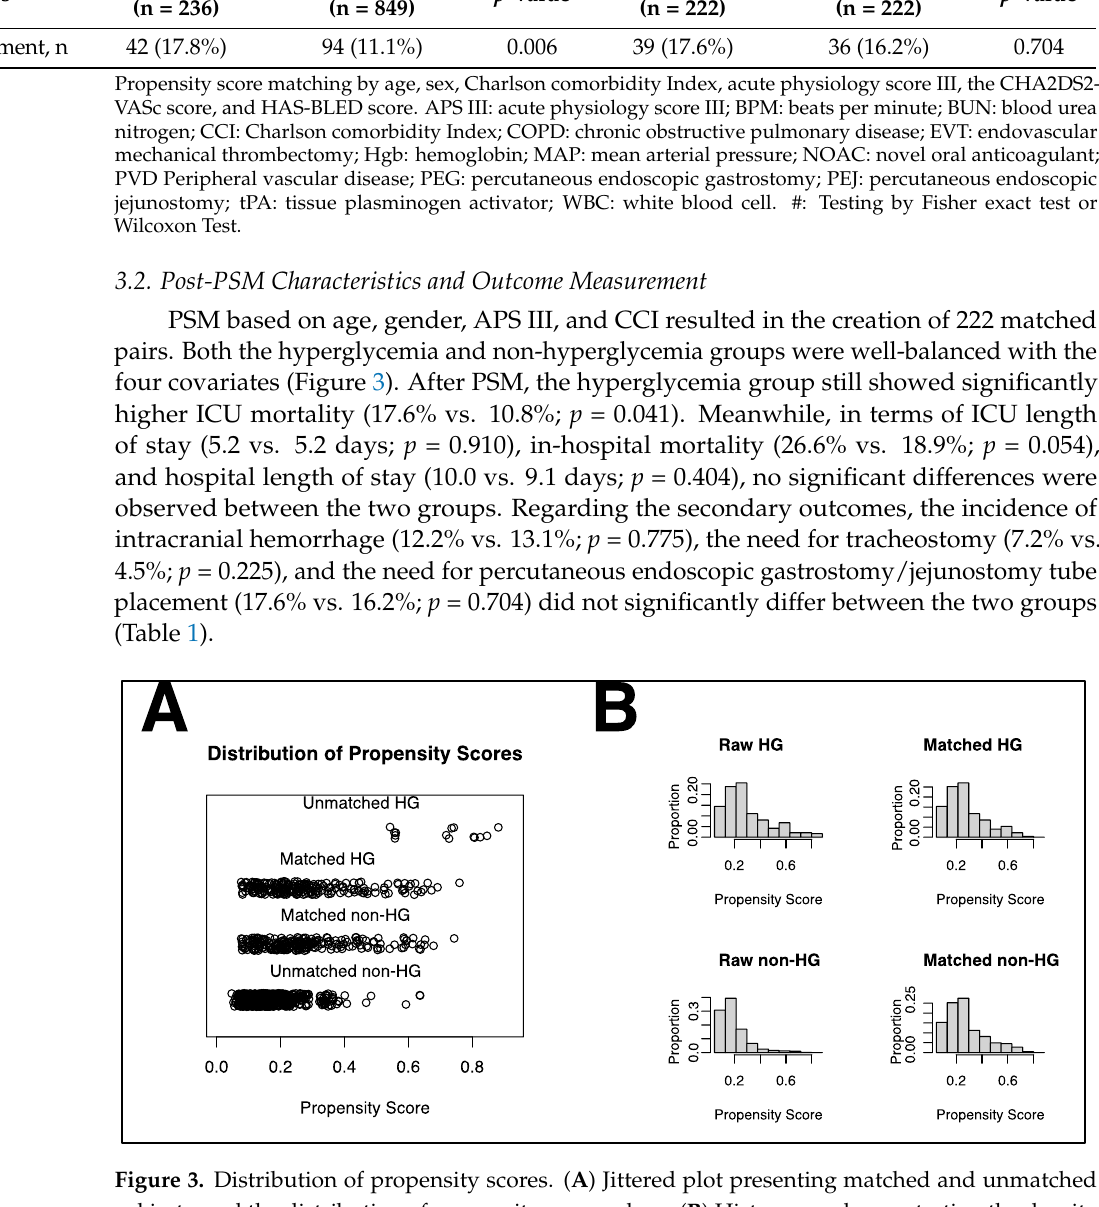
Figure 4. Kaplan – Meier survival curves until intensive care unit (ICU) discharge and hospital dis- charge. ( A ) ICU mortality before propensity score matching (PSM); ( B ) in-hospital mortality before